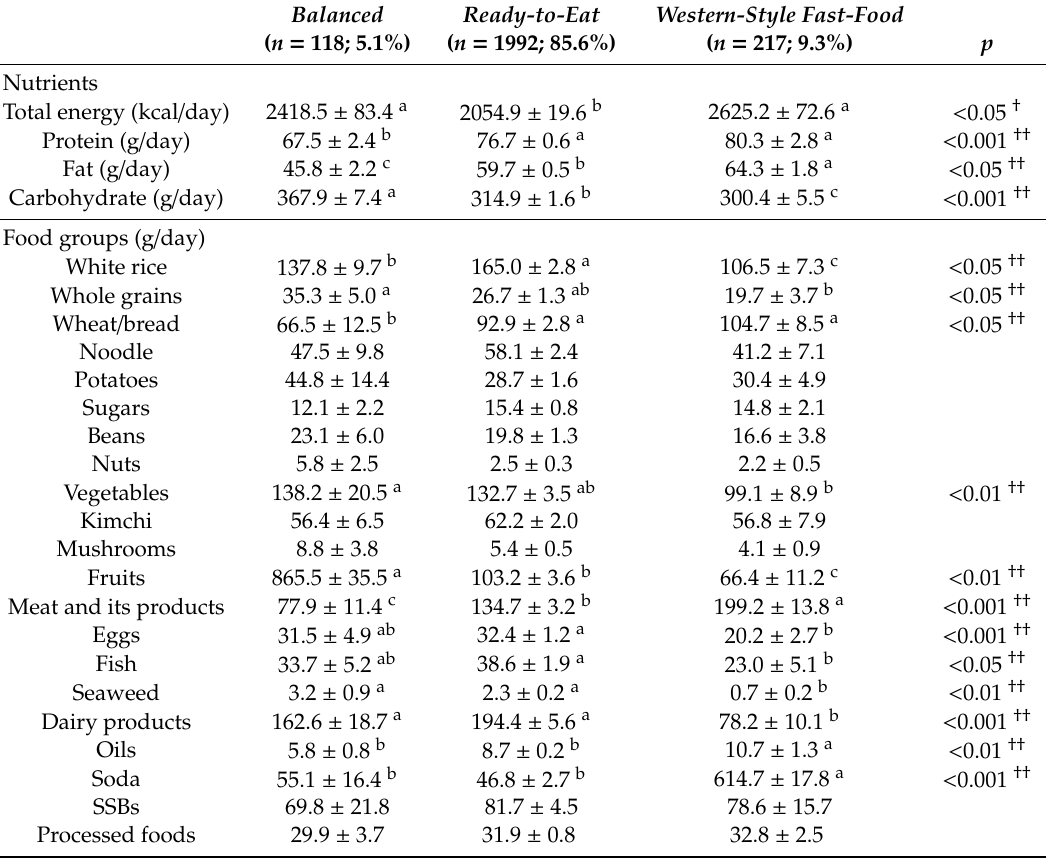
Table 2. Nutrients and food intake of 10–18-year-old children and adolescents according to the three dietary